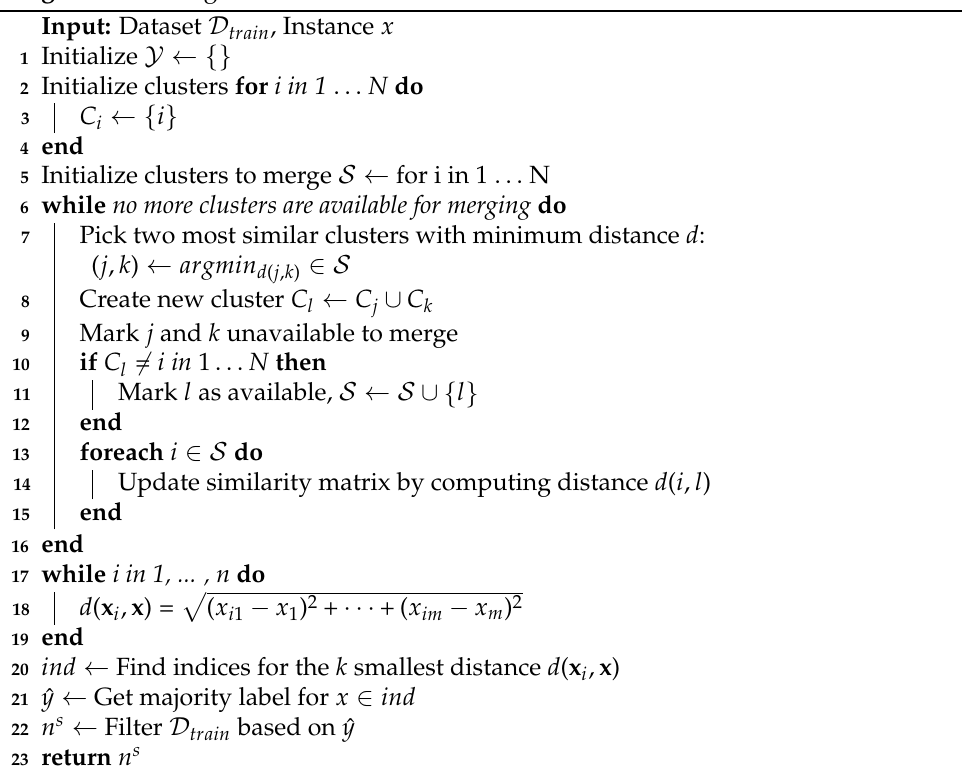
Algorithm 1: Neighbourhood